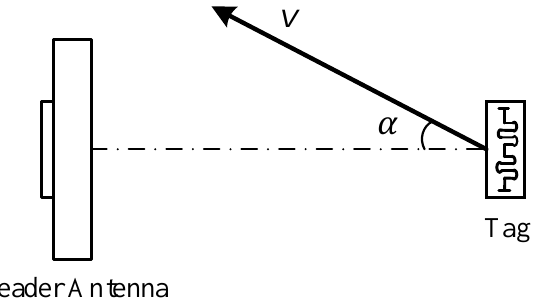
Figure 3. Doppler shift